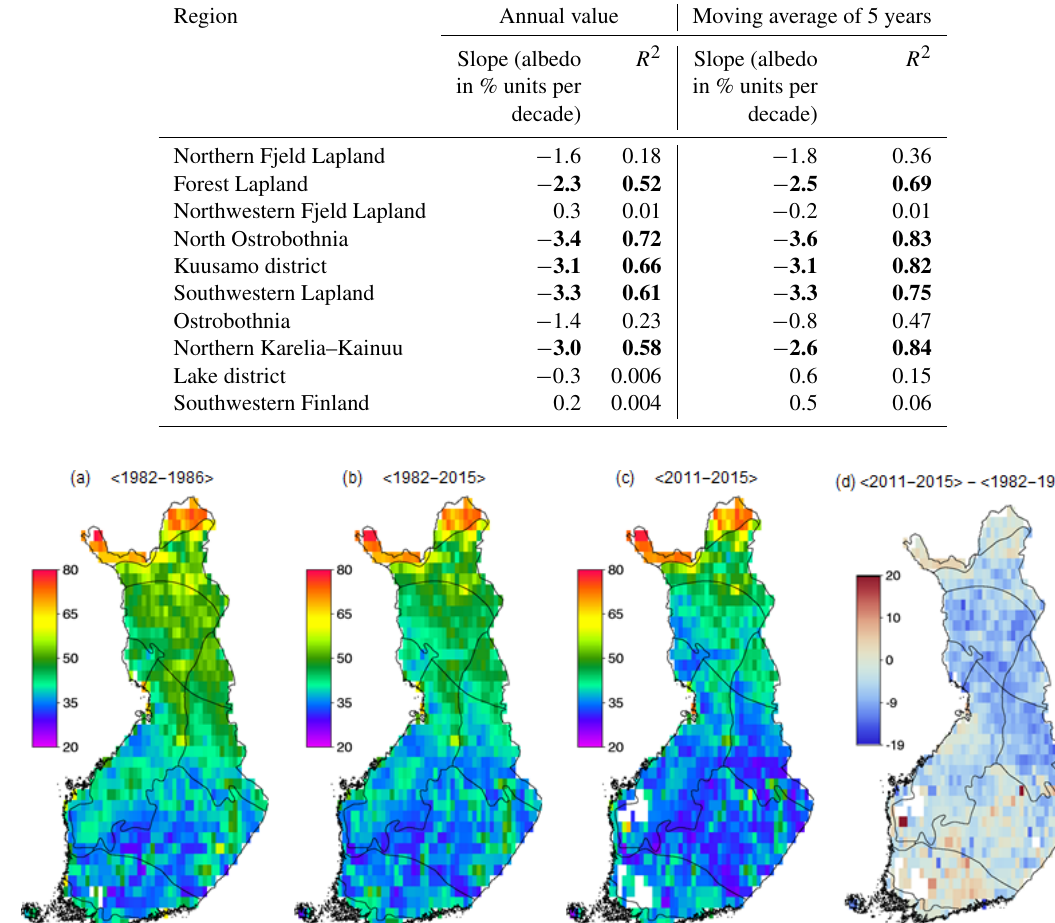
Table 4. The observed albedo trends of regions based on the vegetation zones. Values for the slope and the coefficient of determination are shown both for annual data and moving averages of 5 years. The cases for which the moving average of 5 years shows a significant coefficient of determination are indicated with bold fonts.